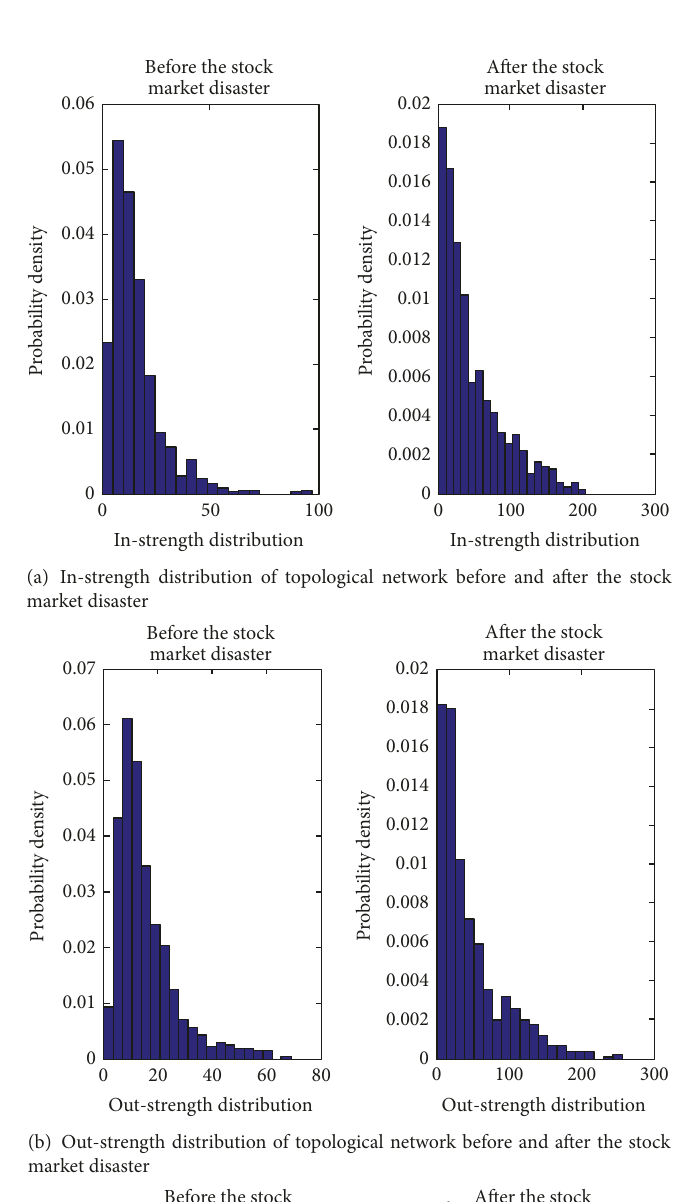
disasterAfter the stock ×10 −3 distributionmarket (c) Strength distribution of topological network structure before and after the stock market disaster Figure 2: